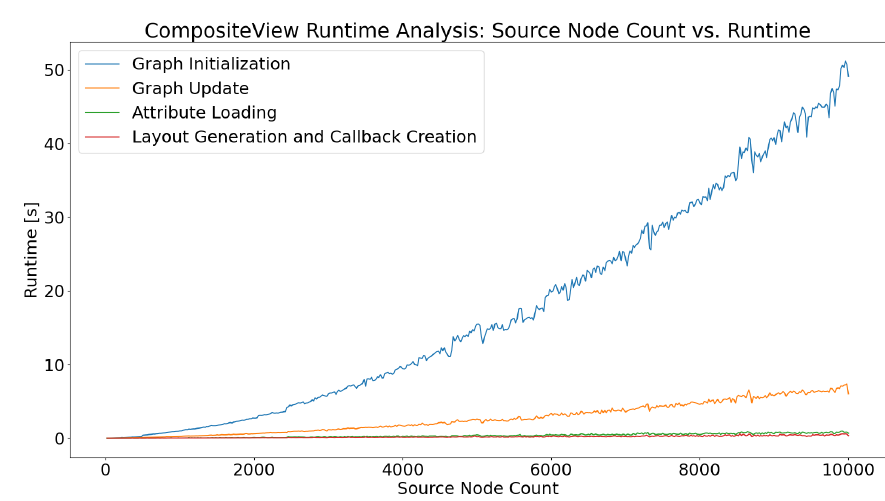
Figure 9. Application startup, graph initialization, attribute loading, and graph